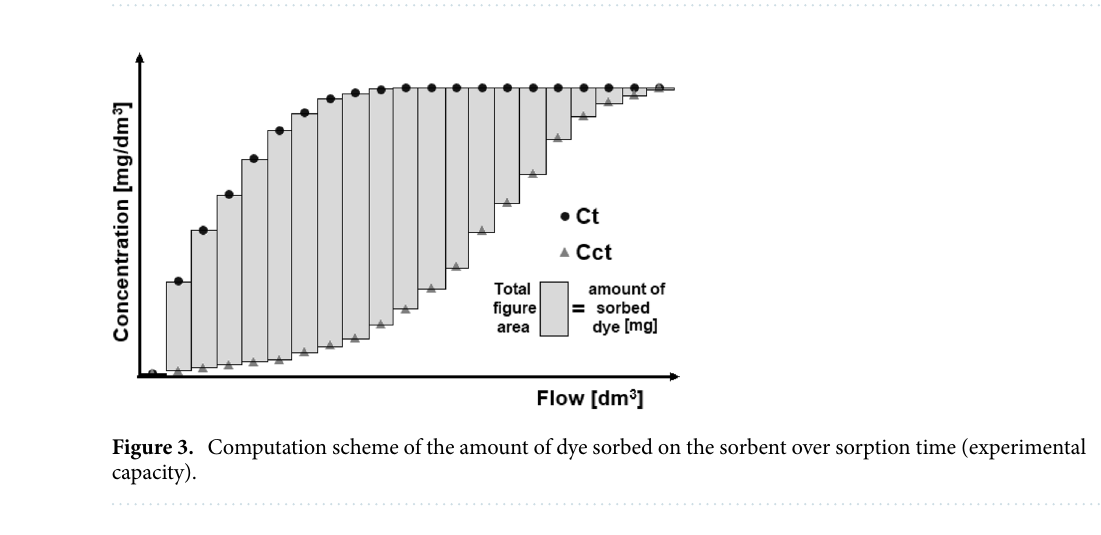
Figure 2. Scheme of the system with the air-lift adsorber.